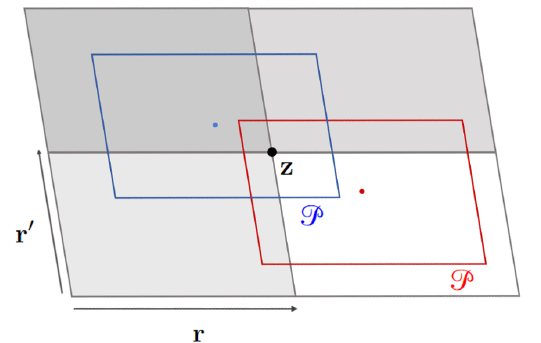
Figure 4 . For a given point of the plane z , all the parallelograms P of sides r , r 0 such that z ∈ P (as the red and the blue one in figure) are such that the centers belong to a parallelogram of sides r , r 0 , centered in z